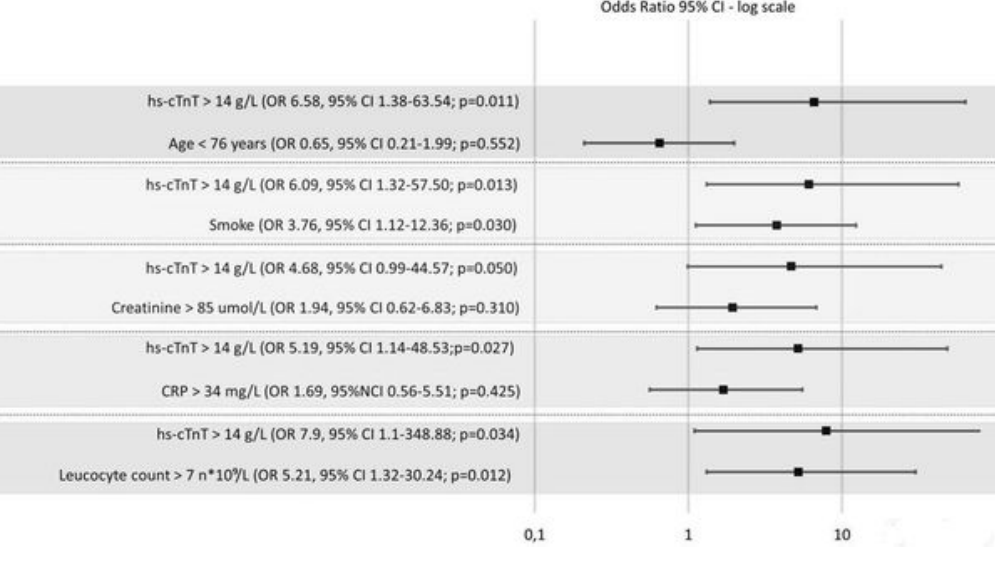
Figure 2. Head-to-head bivariable comparison for the secondary composite endpoint at